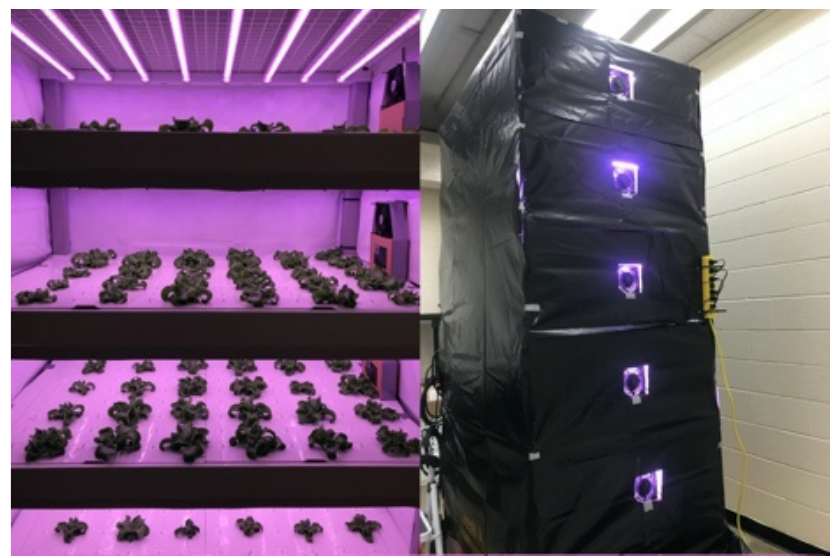
Figure 2. The vertical hydroponic system covered with black and white poly film.